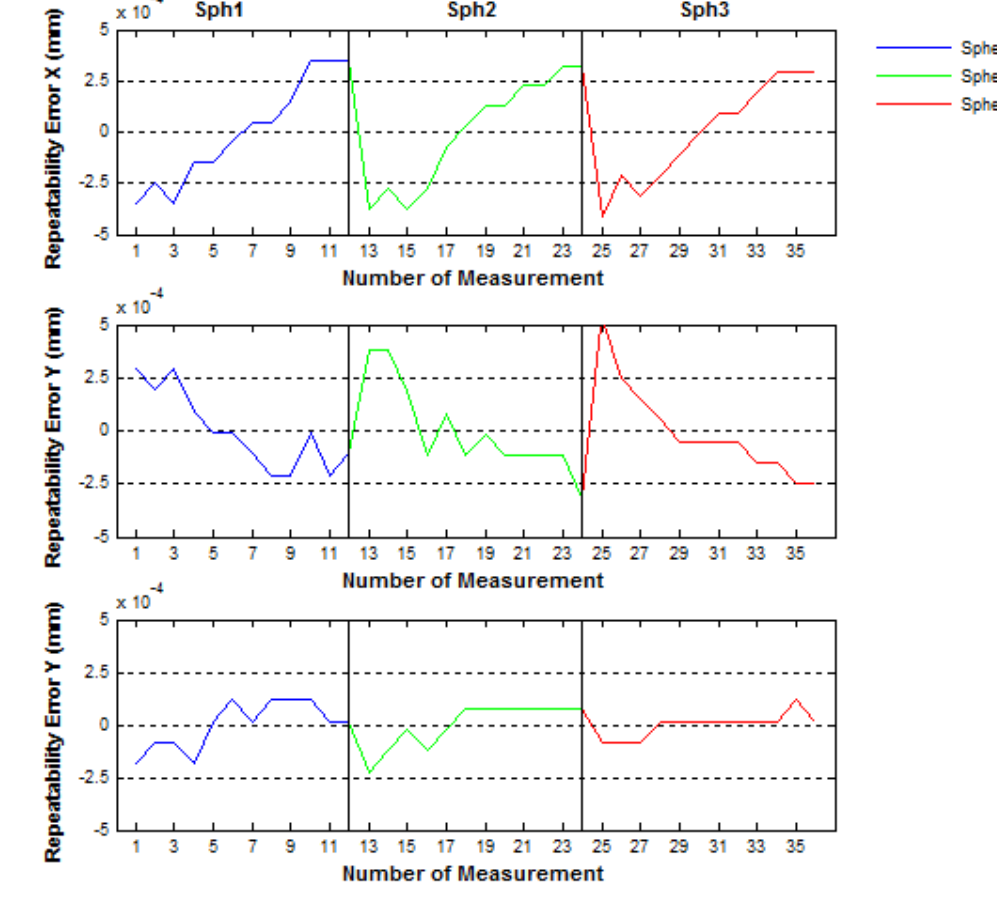
Figure 17. Repeatability errors of the sphere centers measured with the